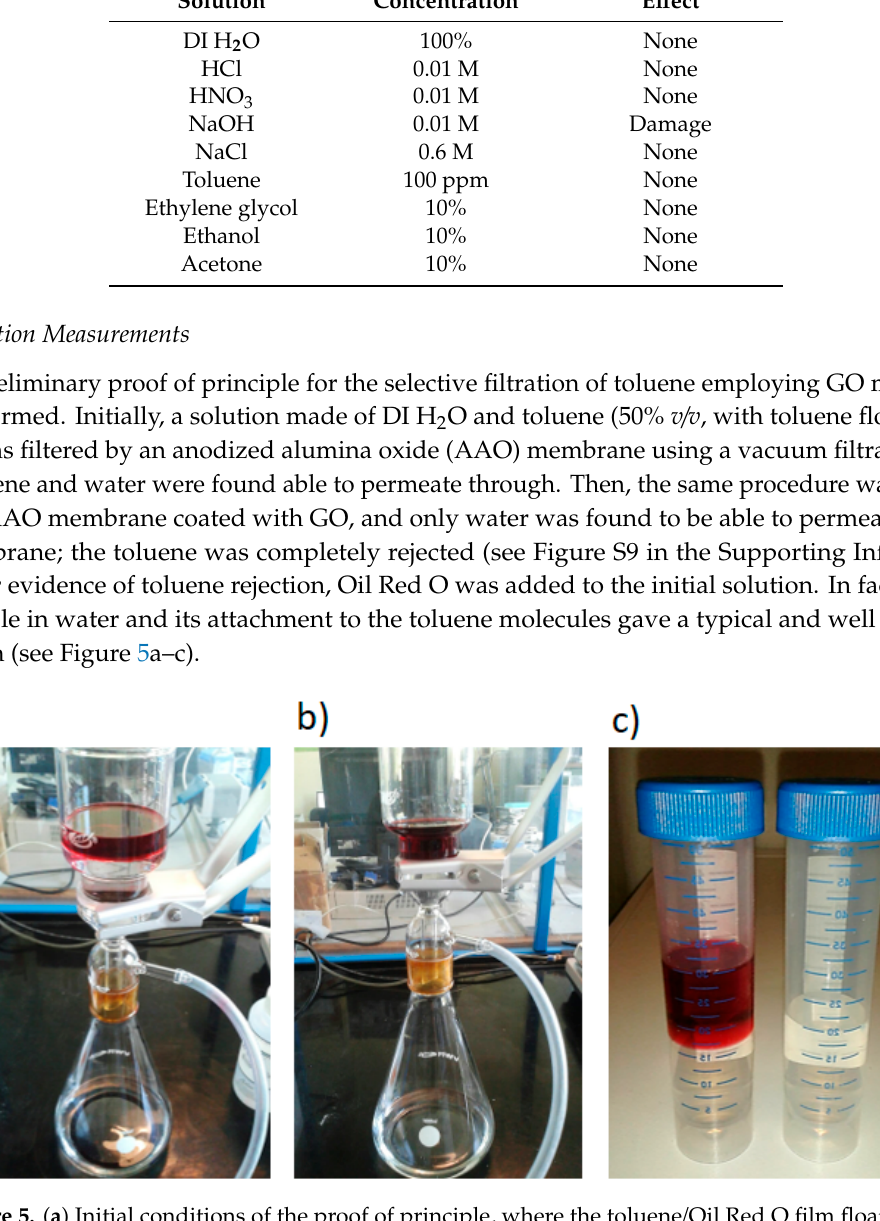
Figure 5. ( a ) Initial conditions of the proof of principle, where the toluene / Oil Red O film floats over DI H 2 O. ( b ) Vacuum filtration using a GO membrane on anodized alumina oxide (AAO) support; only water is collected below. ( c ) Permeates collected by vacuum filtration in ( a , b ) conditions. On the left, a solution of toluene and DI H 2 O filtered with a simple AAO membrane. On the right, the same solution filtered with an AAO membrane coated with GO. No toluene at all was found able to pass through the membrane in the second case.